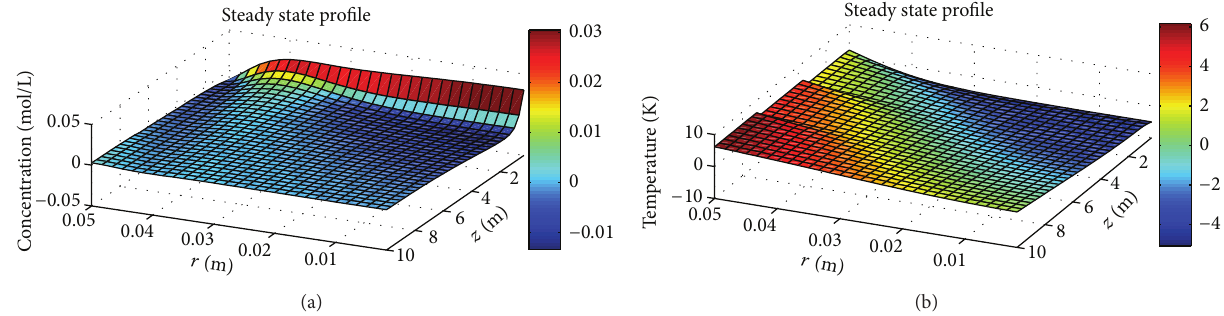
Figure 17: Steady state error (temperature and concentration) for Test 2.